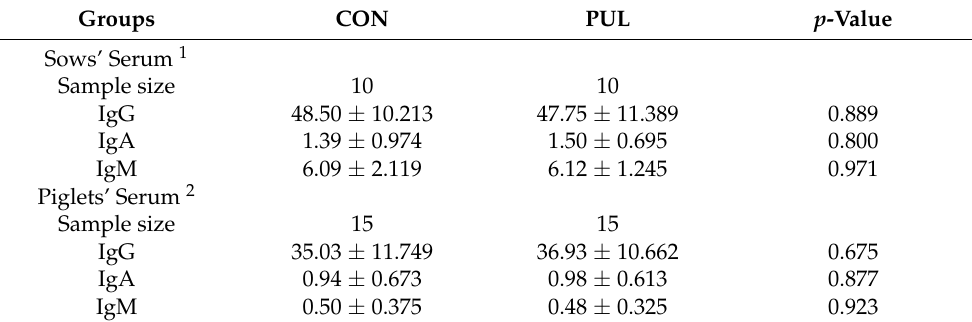
Table 5. Effect of dietary inclusion of olive pulp on IgG, IgA, and IgM levels (mg/mL) in serum of Iberian sows and piglets (mean ± SD).